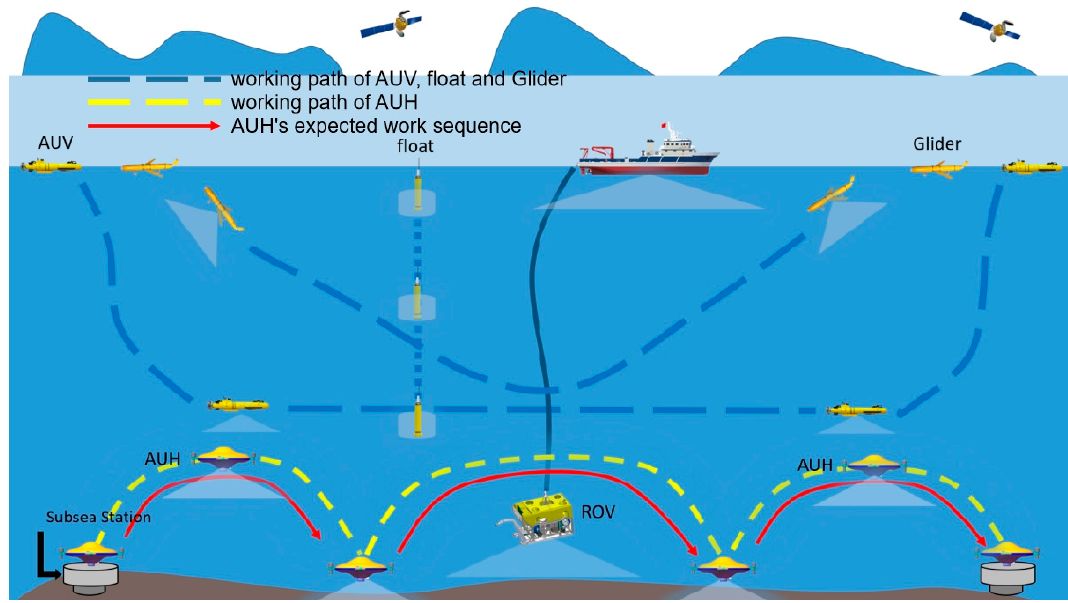
Figure1. AUH’smainworkingpatternandthedi ff Figure 1. AUH’s main working pattern and the differences between AUH and other underwater vehicles.